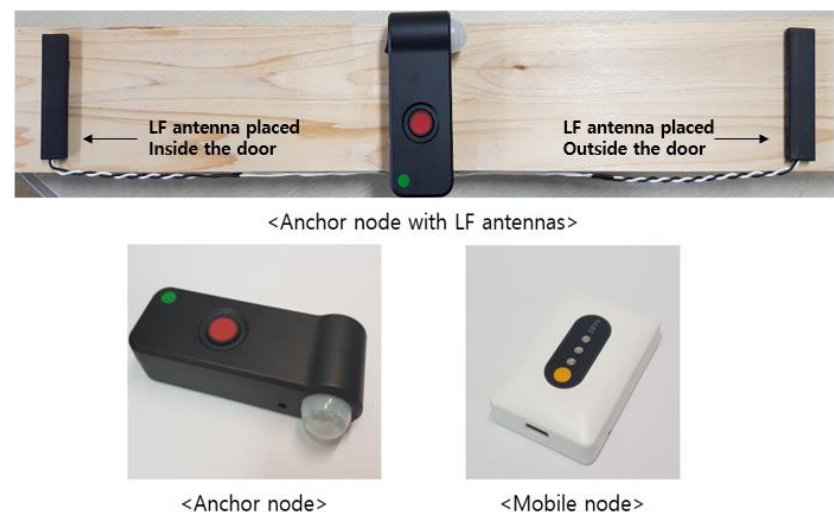
Figure 2. Actual devices of the hybrid SAIL System.